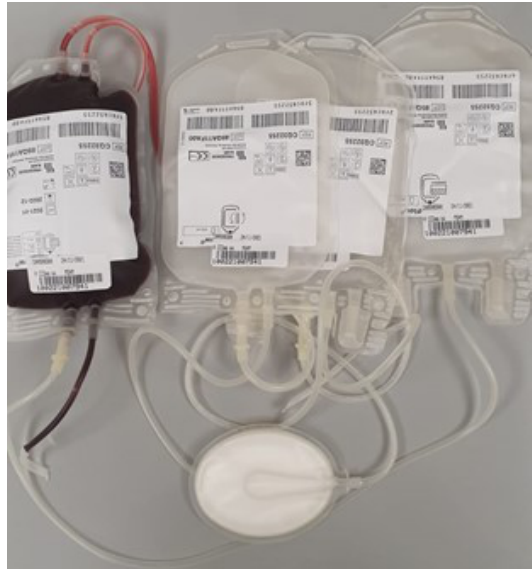
Figure 6. Blood separation to three bags, where the first bag was for plasma, the second one was for buffy coat, and the last one was to keep concentrated